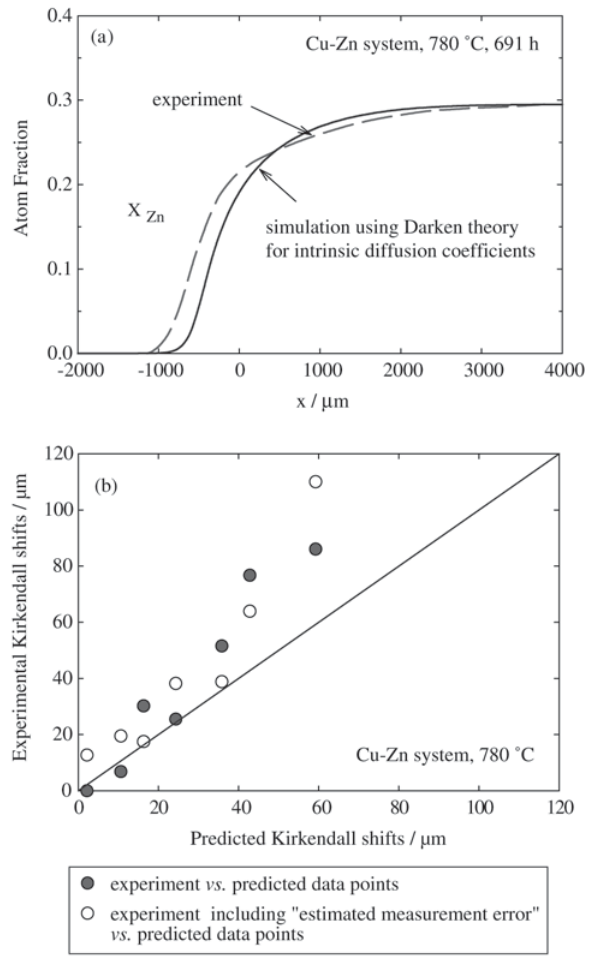
Figure 10. a) Concentration profile and b) Kirkendall shifts using the intrinsic diffusion coefficients obtained from the Darken theory 8,9 as input to the